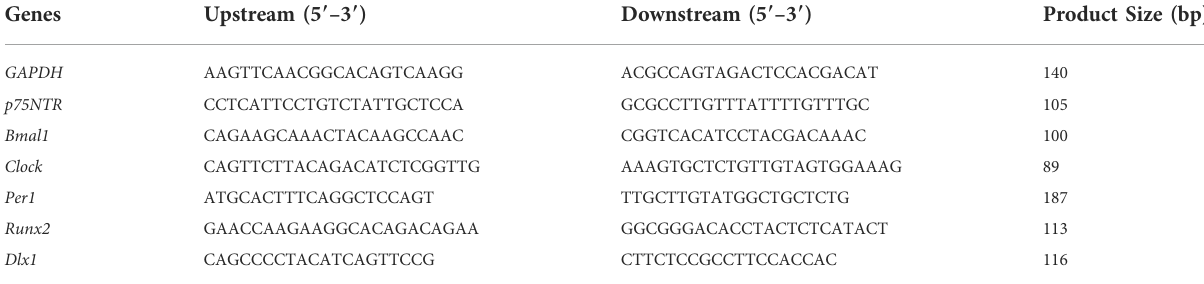
TABLE 1 Rat oligonucleotide primers used in this